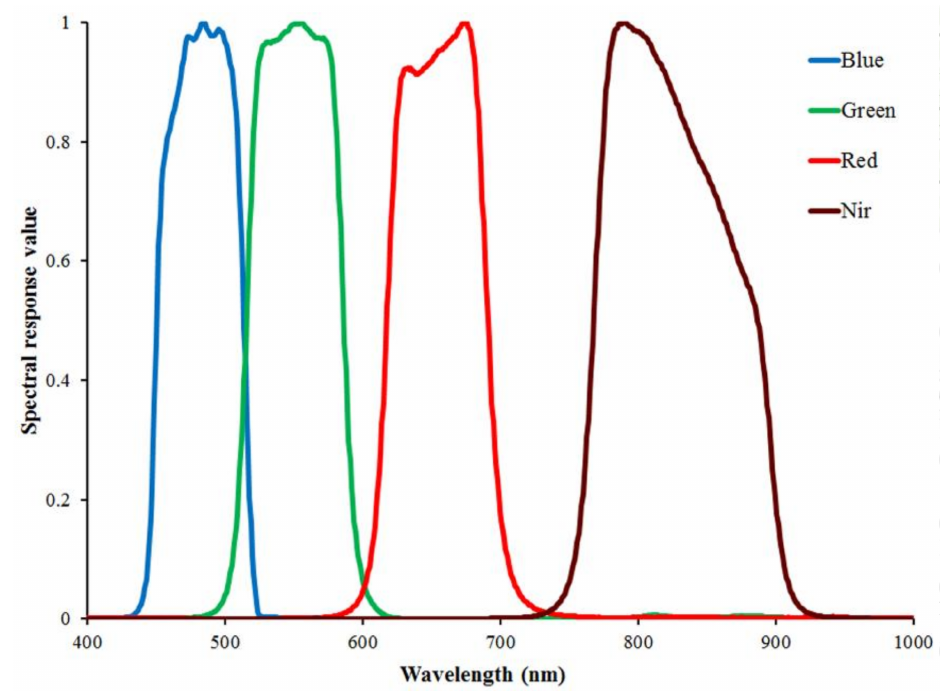
Figure 2. Spectral responses functions of the blue, green, red and near-infrared bands for GF-1